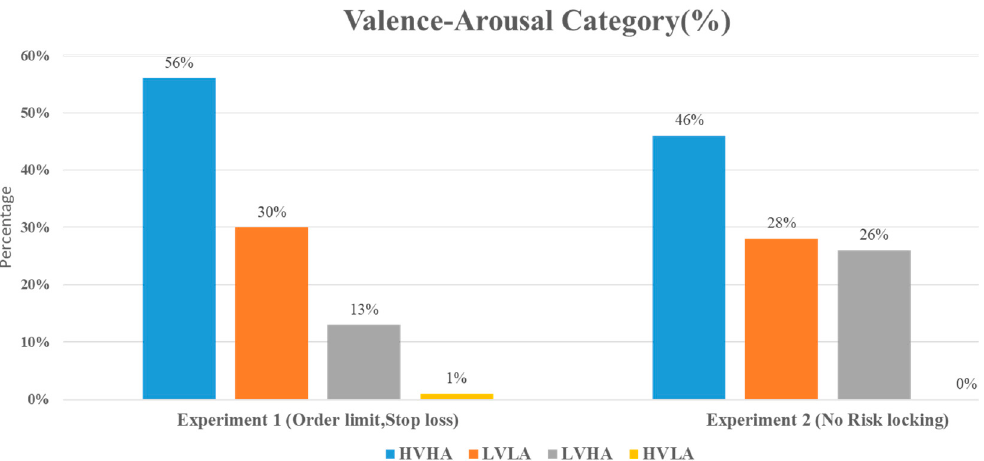
Figure 7. The percentage of valence-arousal category distribution obtained for both experiments conducted with and without risk locking via limit order and stop loss. The second group, which did not use stop loss and limit orders to lock in the risks and book the profits, demonstrated twice (26%) as much Low Valence and High Arousal (the emotion of fear) as the first group (13%), which did utilize these measures.